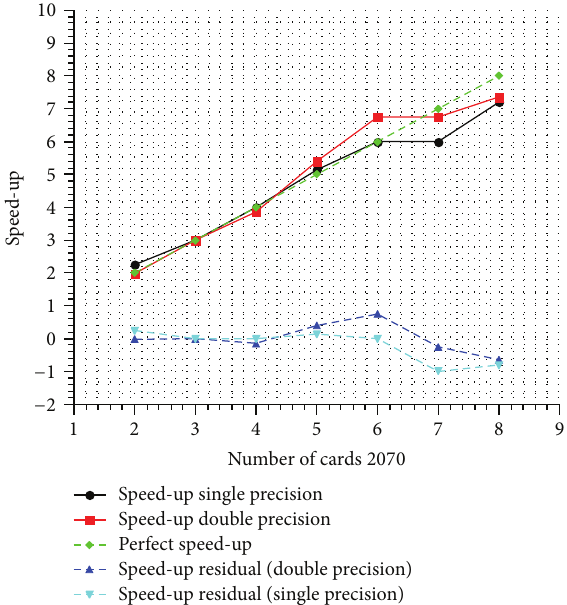
Figure 14: Speed-up obtained using shared and distributed graphics cards, in double and single